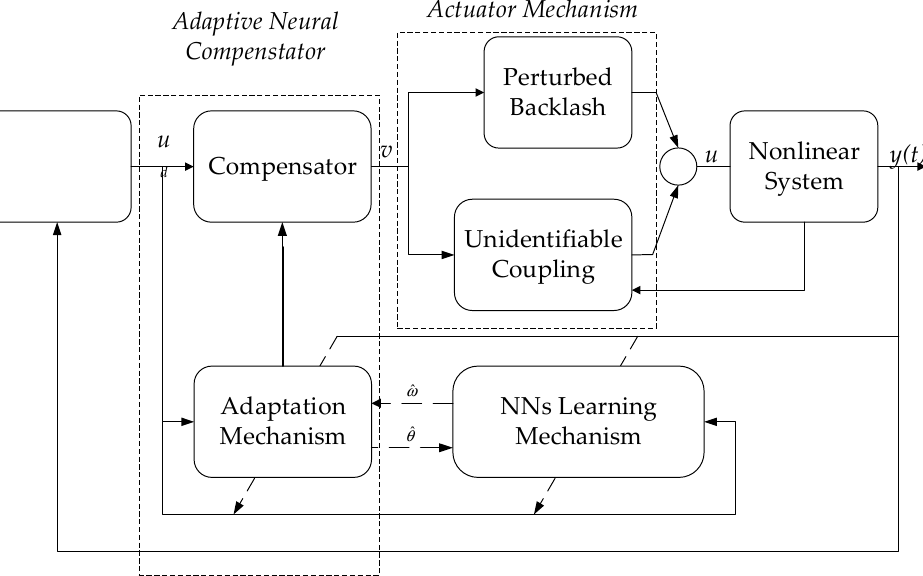
Figure 12. Structure of extreme learning machine-based super-twisting repetitive control (ELMSTRC) system.